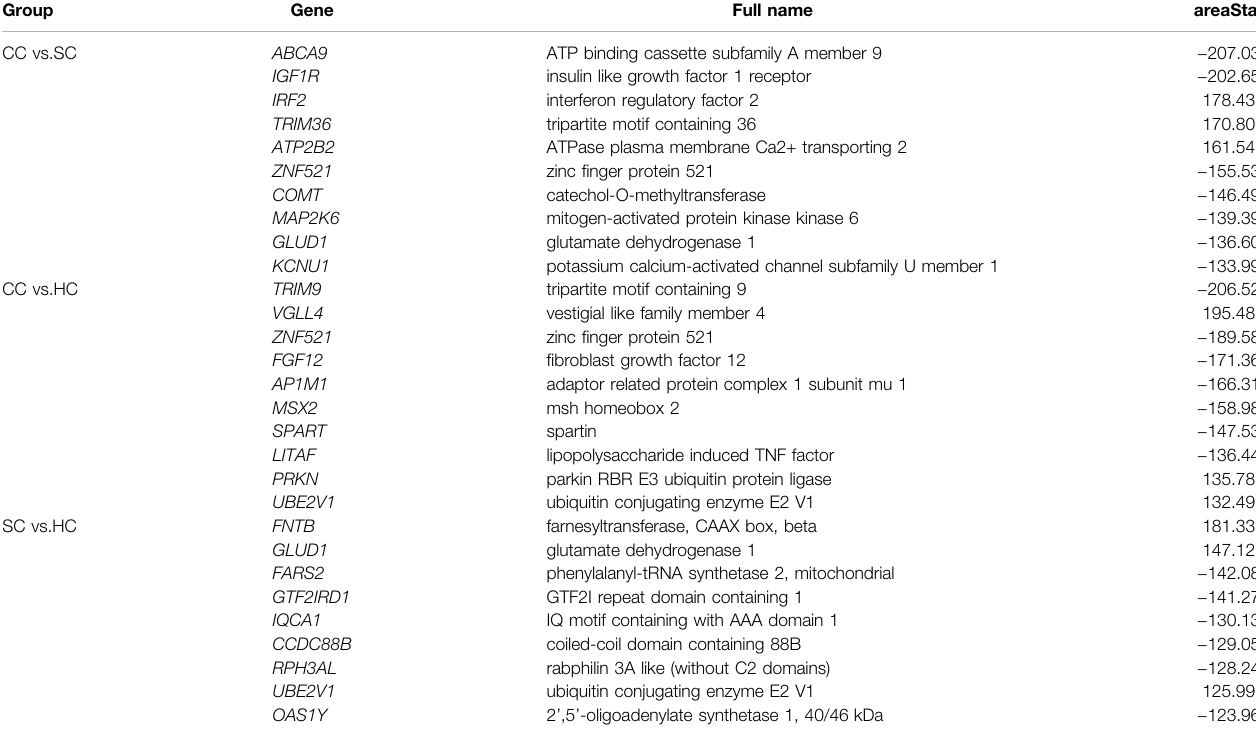
TABLE 2 | The top 10 DMGs among clinical, subclinical, and healthy groups. Group Gene CC